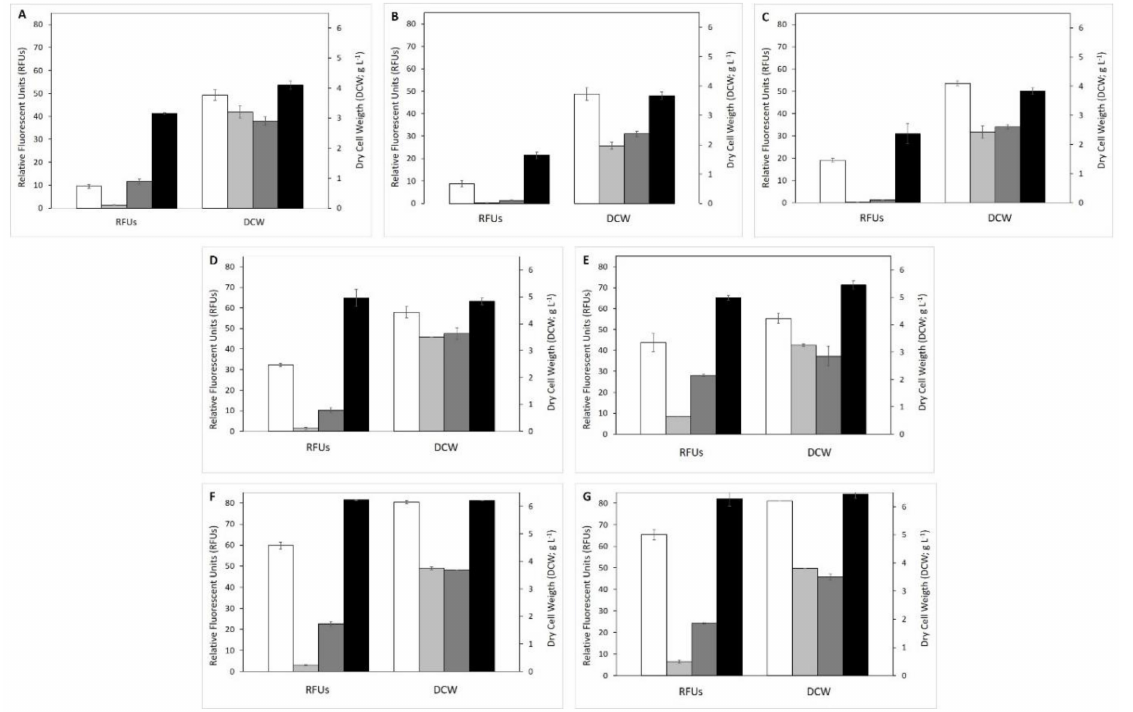
Figure 2. Effect of volatile fatty acids (pure or in mixture) on single cell oil production (relative fluorescent units, RFUs) and yeast growth (dry cell weight, DCW) using the four tested yeast species: white— Apiotrichumbrassicae V134; lightgrey— Candidatropicalis V139; darkgrey— Metschnikowiapulcherrima V213; black— Pichia kudriavzevii V194. Letters indicate the medium in which yeasts were grown, during 120 h: ( A ) YP:HAc (5.1 g L − 1 ); ( B ) YP:HPr (2.7 g L − 1 ); ( C ) YP:HBut (3.5 g L − 1 ); ( D ) YP:HAc:HPr; ( E ) YP:HAc:HBut; ( F ) YP:HAc:HPr:HBut; ( G ) YP:HAc:HPr:HBut:isoHbut (0.2 g L − 1 ):HVal (0.9 g L − 1